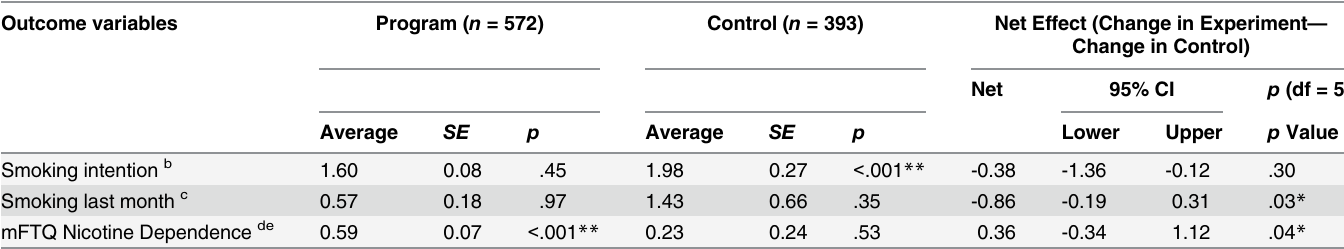
Table 3. Program Effects Adjusted for Imbalance in Attrition a